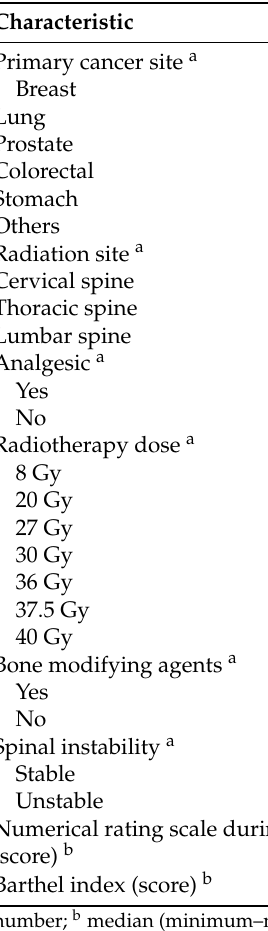
Table 1. Characteristics of the patients with bone metastases before radiotherapy.